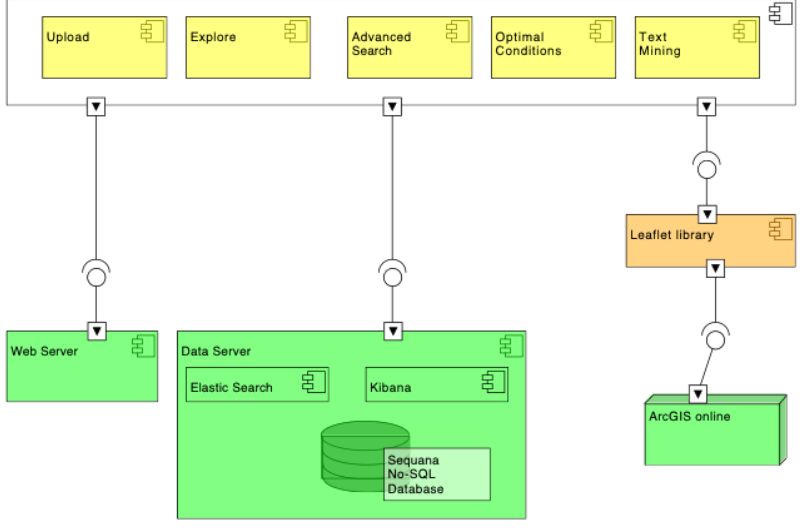
Figure 2. DKP n -tier architecture—components and